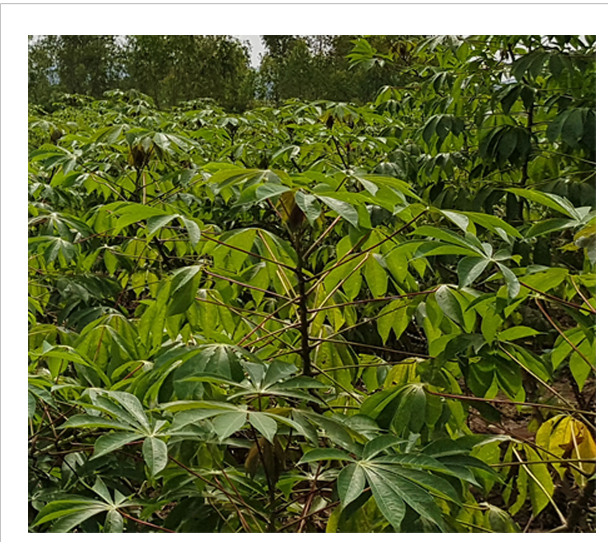
FIGURE 3 The advanced breeding line KBH 2016B/521, 6 months after planting in an epidemic zone for CBSD and CMD near Uvira, DR Congo. The line is free of symptoms after 3 consecutive growing